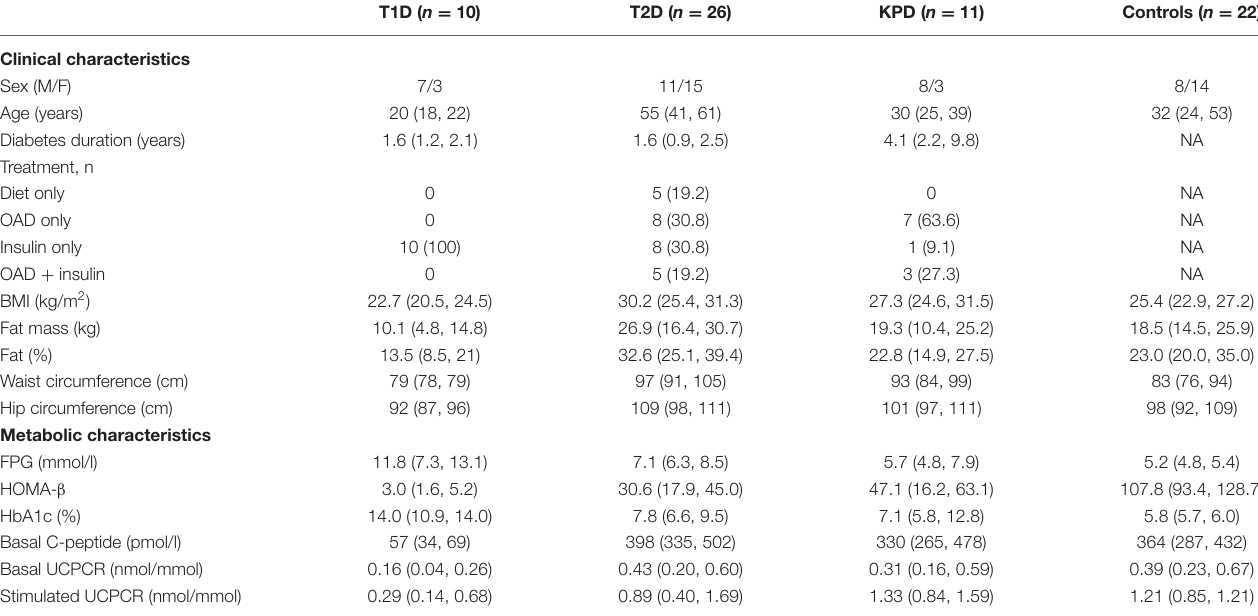
TABLE 1 | General characteristics of the study